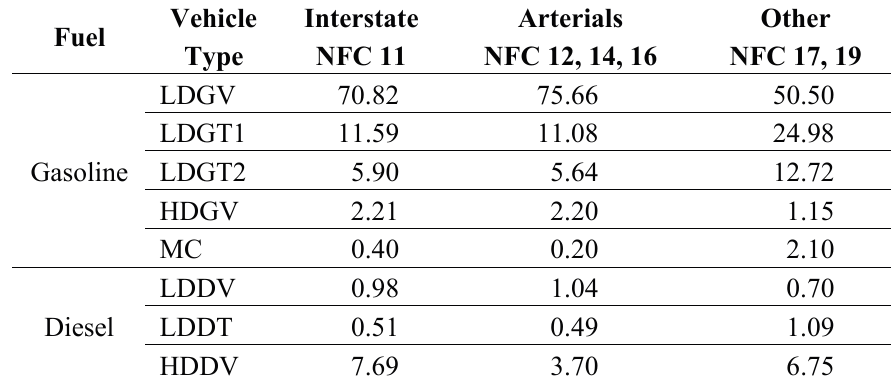
Table 4. Fleet-mix results for urban roadways in Detroit, MI (percentages),